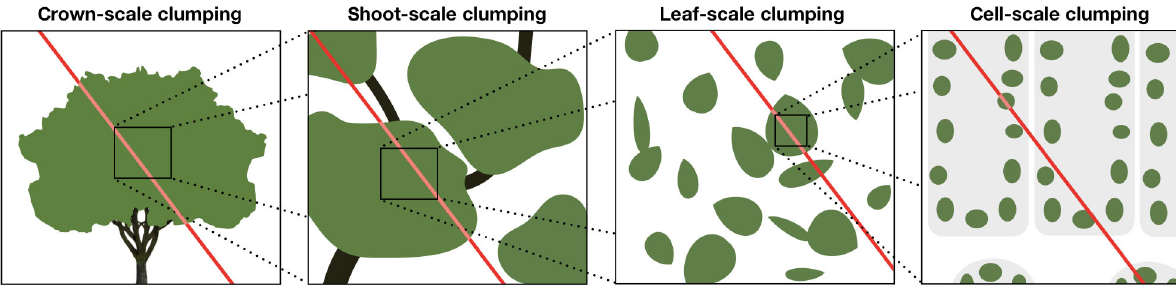
Figure 1. Hierarchical scales of spatial aggregation or clumping in a plant